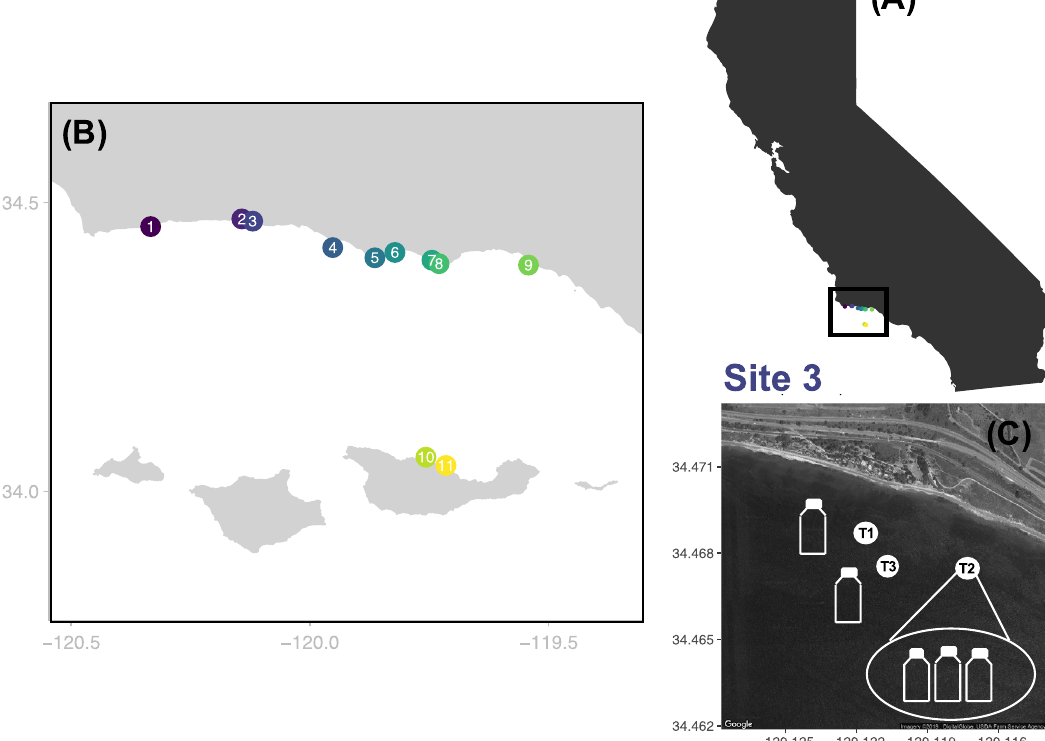
Figure 1. Hierarchical distribution of sampling within the Santa Barbara Channel (SBC), California. ( A ) Location of the study area along the California coastline. ( B ) Distribution of the 11 rocky reef sites within the SBC. Fish communities were visually surveyed at two to three transects within each site (N = 27 transects). Triplicate water samples were collected within one transect and single water samples were collected in the remaining transects for eDNA metabarcoding (N = 49 bottles). ( C ) Close up of site 3 where fish communities were visually surveyed and eDNA sampled at three transects. Triplicate water samples were collected at transect 2 and single water samples were collected at transects 1 and